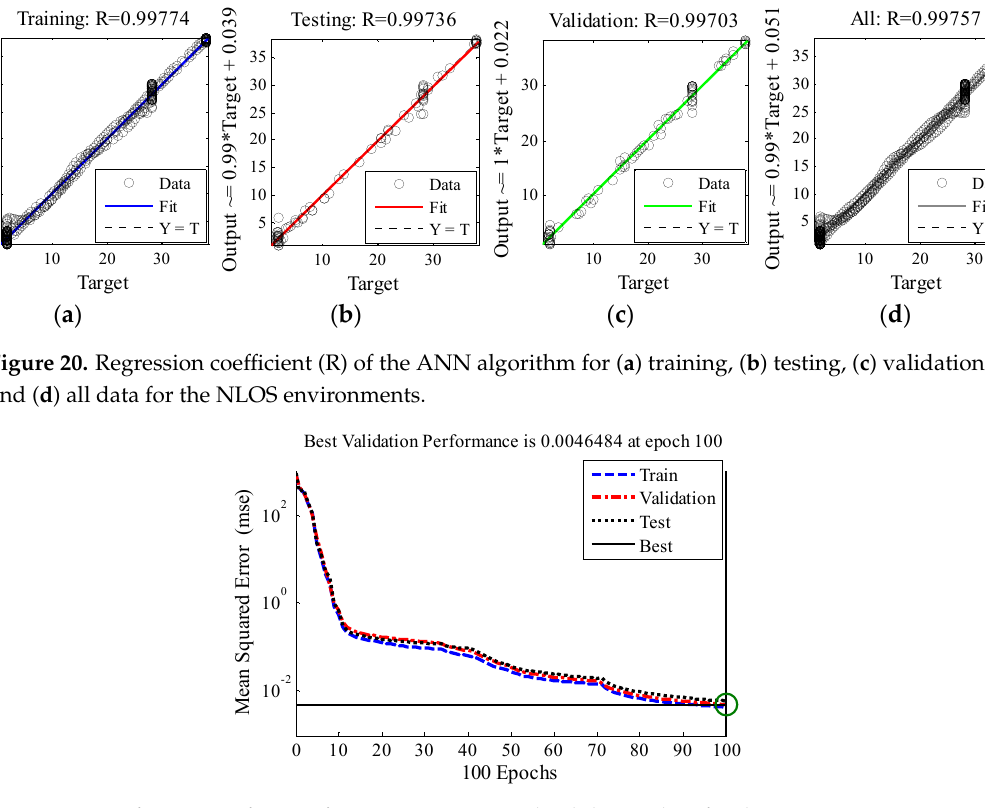
Figure 21. Performance of MSE of training, testing, and validation data for the NLOS environments.